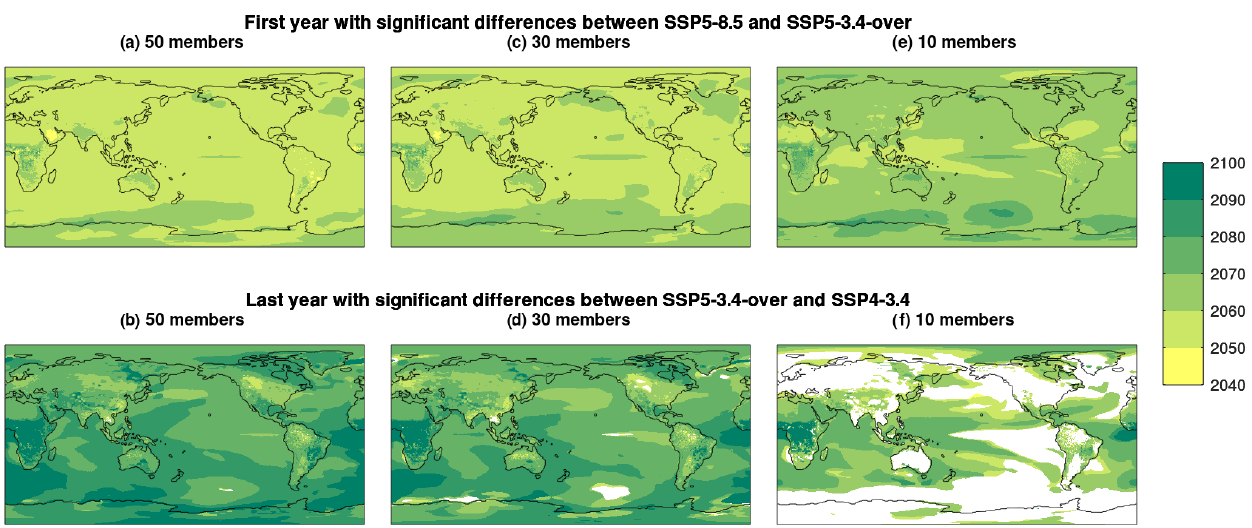
Figure 7. Year of the emergence of significant temperature differences between SSP5-8.5 and SSP5-3.4-OS (a, c, e) , and the year when the temperature differences between SSP4-3.4 and SSP5-8.5-OS cease to be significantly different (b, d, f) . The results for the full ensemble (50 members) are shown in (a, b) . The results assuming ensembles with the same ensemble mean and variance are shown in (c, d) assuming 30 members and in (e, f) assuming 10 members. White color denotes regions where the differences between SSP4-3.4 and SSP5-8.5-OS are never